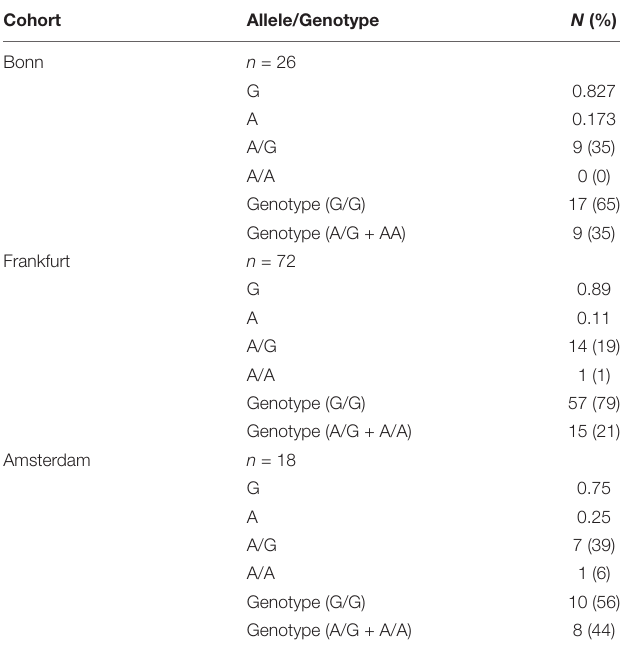
TABLE 1 | Frequency of alleles and genotypes for gap junction protein alpha 4 at position rs41266431 in 3 CF cohorts.